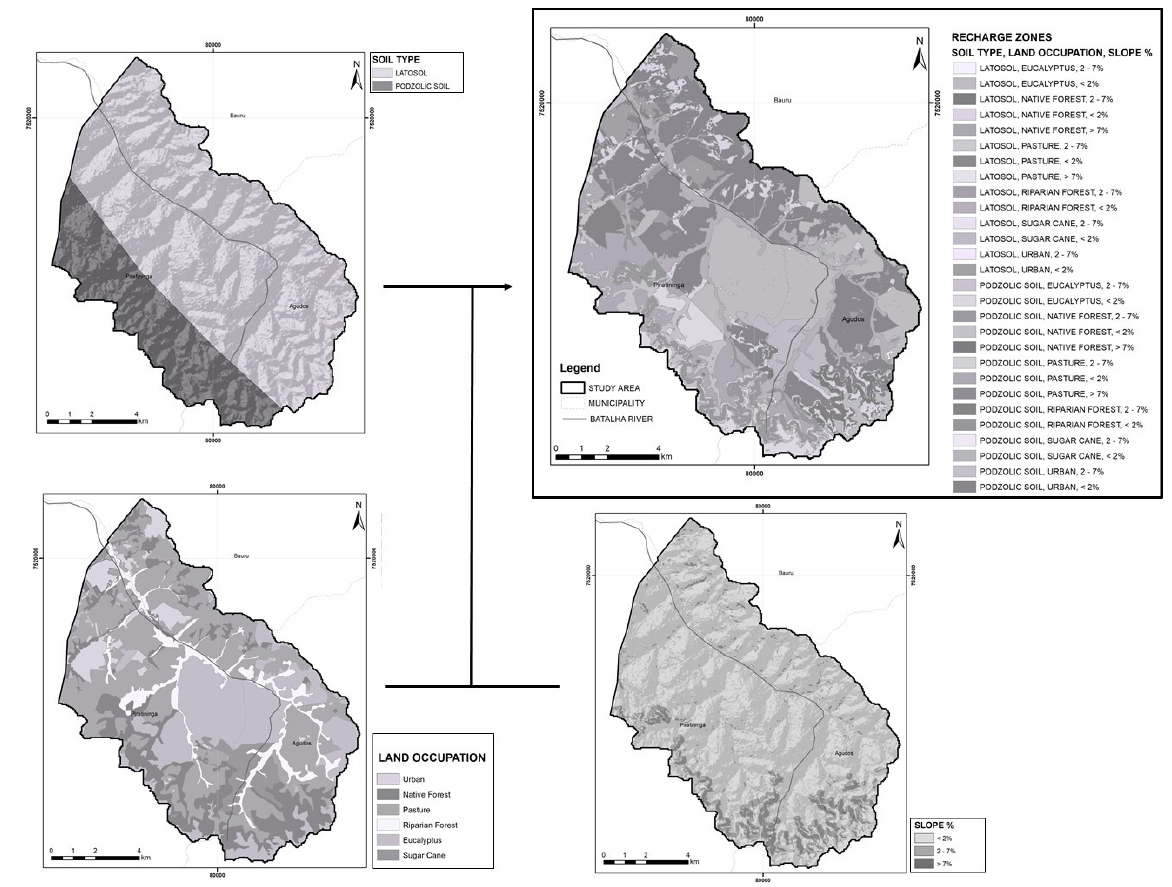
Figure 3. Scheme of integration to define the recharge zones based on the terrain slope, soil type, and land use